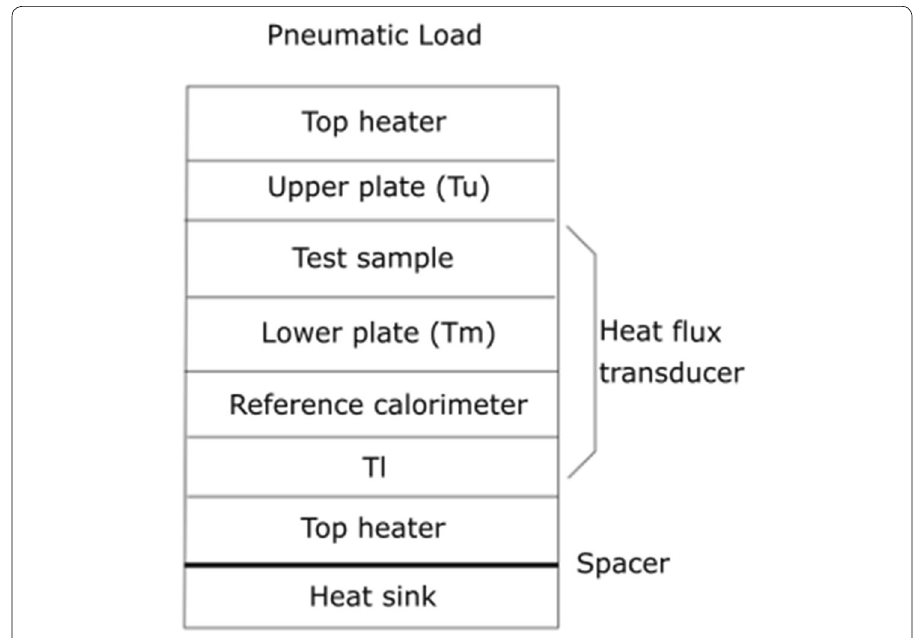
Fig. 1 Apparatus used—surrounded by guard